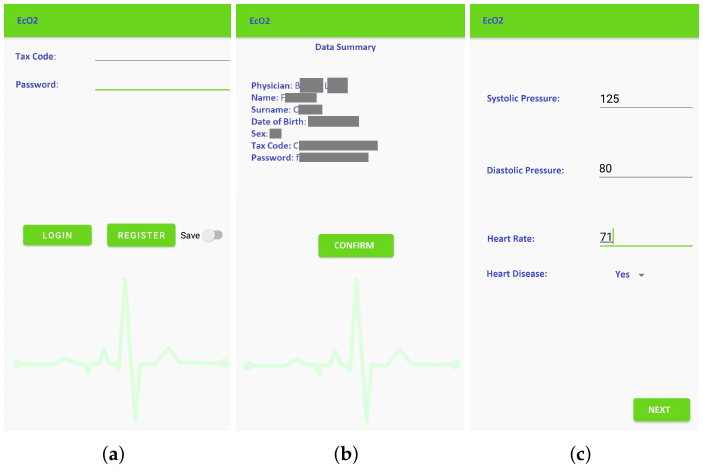
Figure 4. Window of the EcO2u mobile application: Main menu of the application ( a ); Patient registration (sensitive data are hidden) ( b ); Data calibration ( c